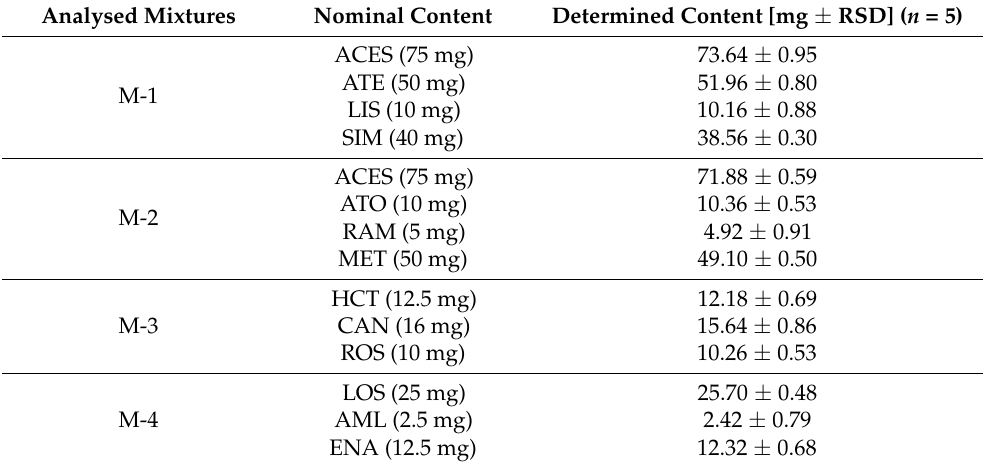
Table 6. Application of the proposed HPLC-DAD method for the determination of APIs in laboratory- prepared mixtures of polypill